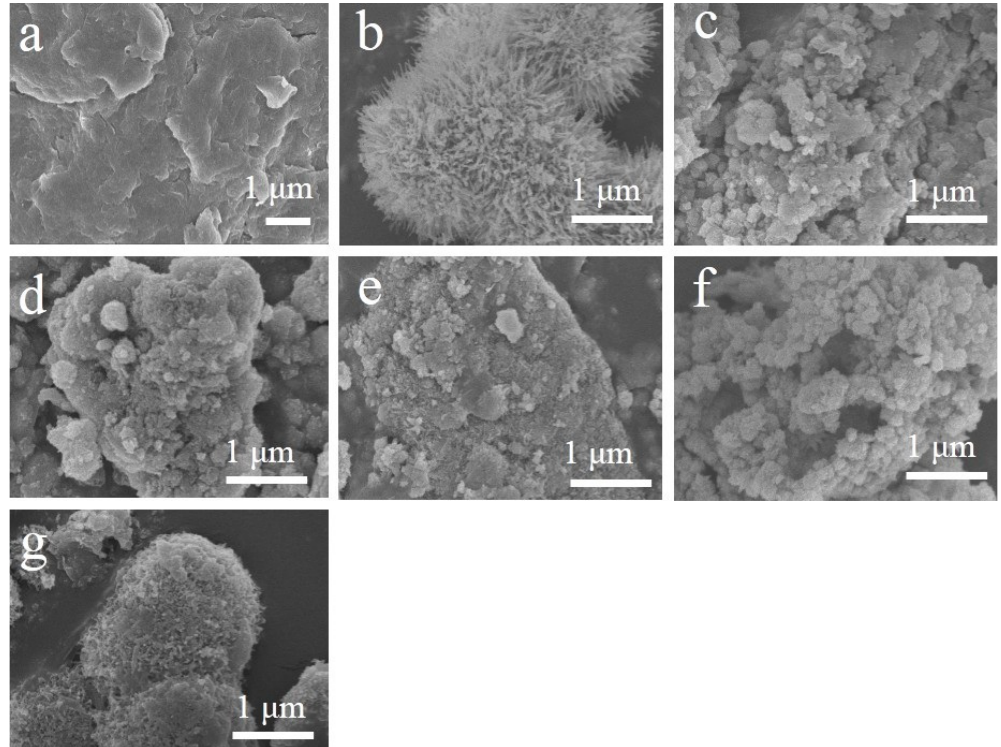
Figure 3. Scanning electron microscope (SEM) images of ( a ) rGO, ( b ) TiO 2 , ( c ) ITO-rGO and TiO 2